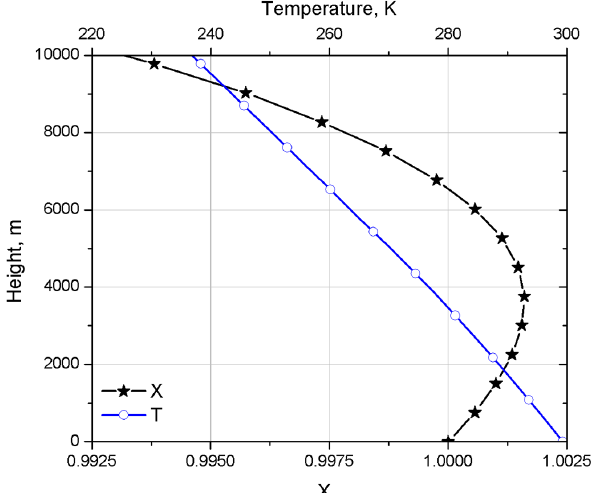
Figure 6. Temperature profiles (open symbols) and errors of extinc- tion coefficient calculation (cid:49)α T due to height variation of temper- ature (solid lines). Computations were performed for US Standard Atmosphere temperature profile (black) and for temperature mea- sured by radiosonde on 5 January (blue) and 10 July 2013